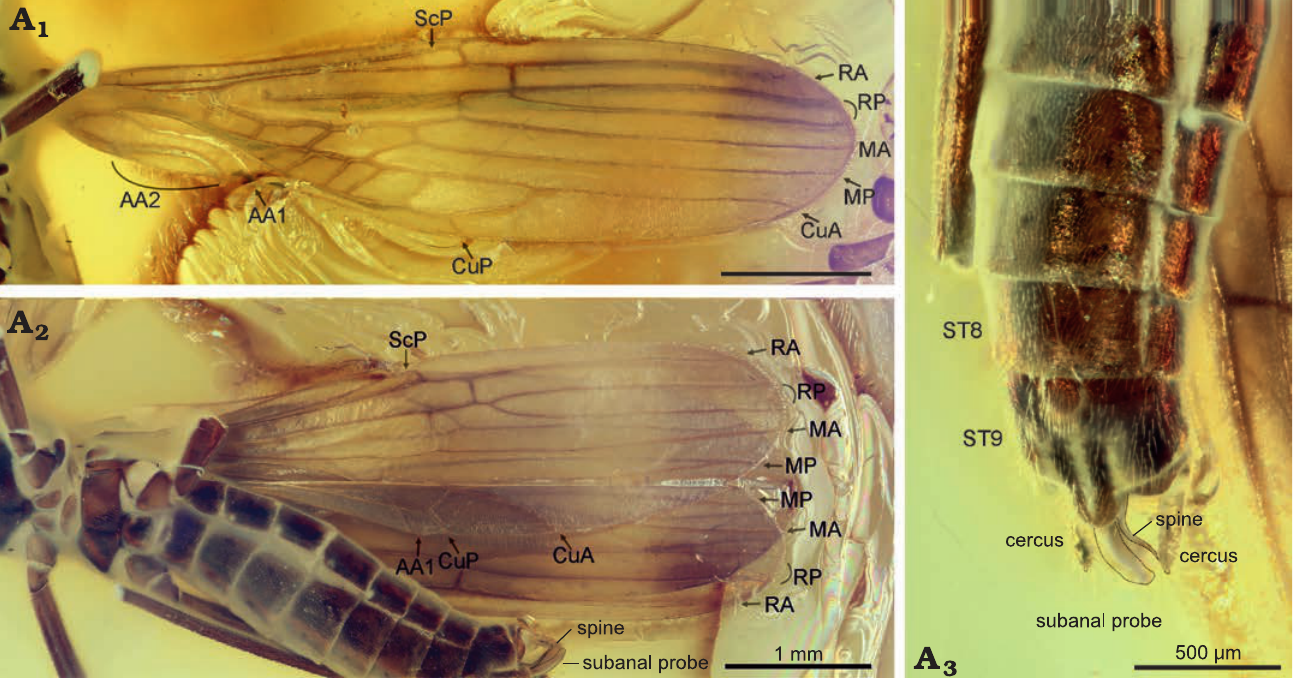
Fig. 4. Needle stonefly Baltileuctra foraminis Chen, 2018a (ICJUST CZT-PLE-BA2) from Eocene Baltic Amber from unknown locality in Lithuania. Male adult, photomicrographs of left forewing in dorsal view (A anal probe, lateral spines, and apical cercal spines indicated with black